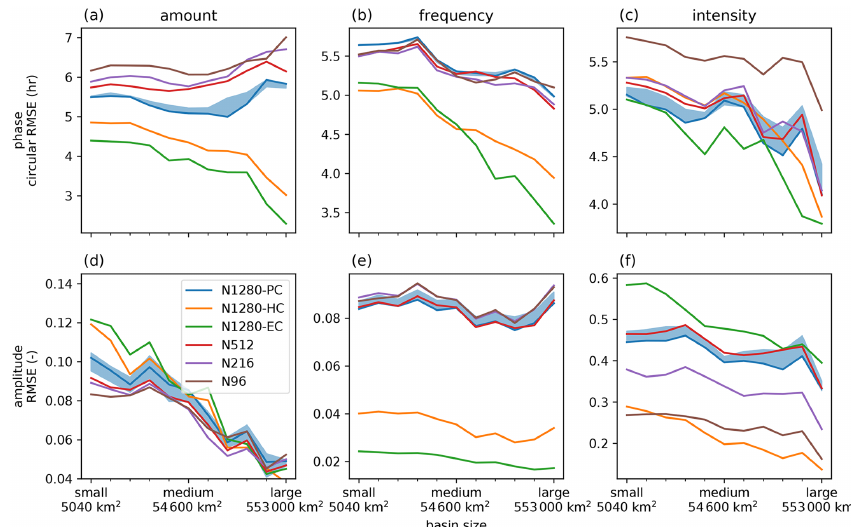
Figure 8. Basin error statistics (Sect. 2.4.4) of the diurnal cycle phase and amplitude of each simulation compared to CMORPH shown as a function of basin scale. Amount, frequency and intensity are shown in each column, and the error statistics appropriate for phase, amplitude and both combined are shown in each row. Light blue shading shows the maximum spread for the three N1280-PC ensemble members. The basin names and median basin sizes are shown on the x